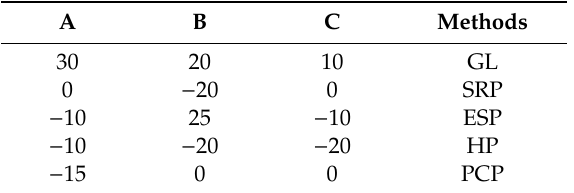
Table 7. The percentage of changes in the parameters of the new well.